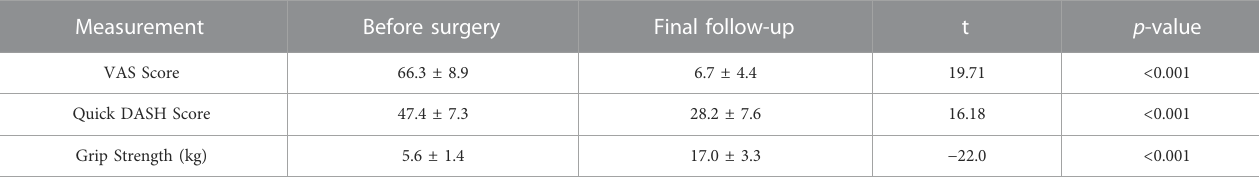
TABLE 2 Comparison of VAS score, quick dash score, grip strength before surgery and fi nal follow-up a .